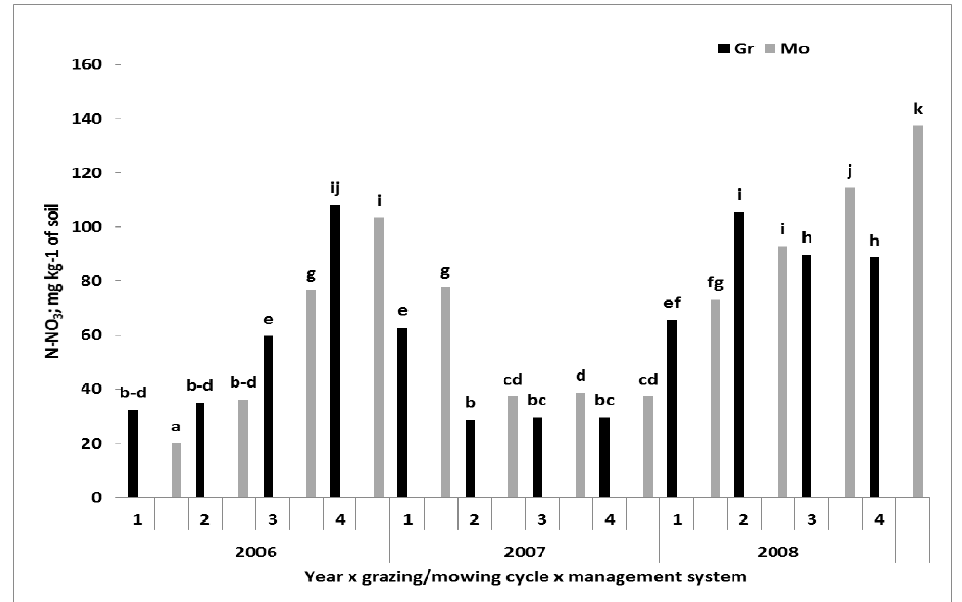
Figure 4. Effect of the grassland management in consecutive cuts in the growing season on the nitrate content. a The same letter indicates a lack of significant differences within the treatment ( p < 0.05).